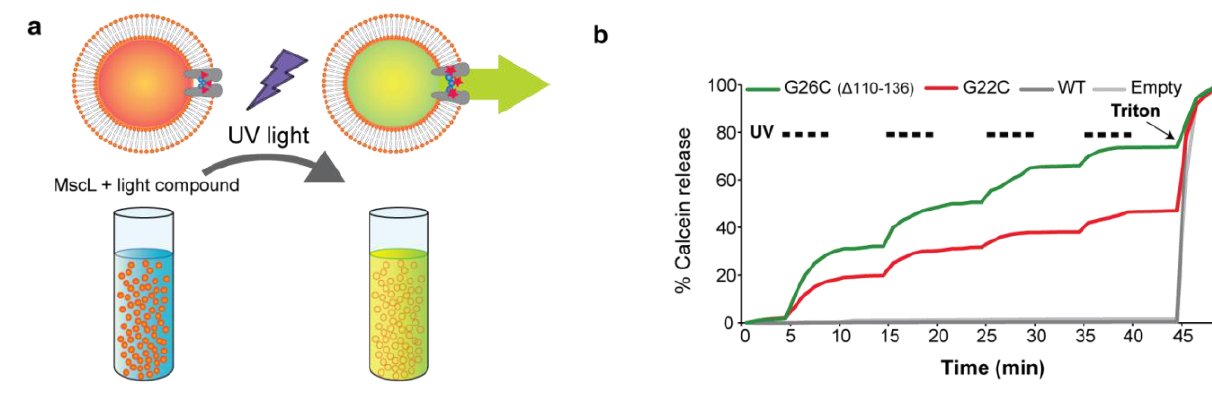
Figure 6. Efflux efficiency through G22C and G26C (Δ110-136) (MscL light activated nanovalves in artificial liposomes. ( a ) The scheme represents the efflux of the self-quenching dye calcein from MscL proteo-liposomes. MscL channels modified with a light-compound are gated by pulses of UV light. Calcein released through the channel is diluted giving a fluorescence signal. ( b ) Calcein efflux through G26C (Δ110-136) and G22C MscL modified with a light sensitive compound was measured. Proteo-liposomes filled with calcein containing no protein (empty), WT, or light-compound modified G22C or G26C (Δ110-136) MscL were treated with UV light (336 nm) pulses of 5 min of duration. Triton was added at the end of the experiments to control for the liposomes loading with the